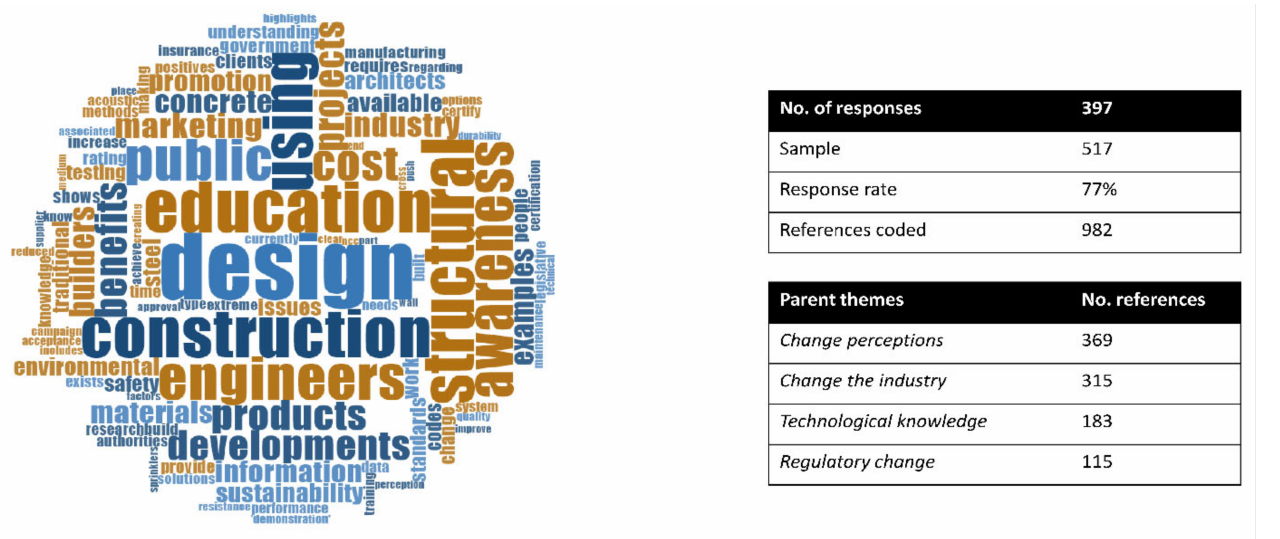
Figure 12. Word Cloud: what can be done to improve adoption of timber in medium and high-rise markets? In the responses, the top-ten most used words relevant for the adoption of timber in multi-storey buildings are: ‘design’ (word count: 83), ‘education’ (79), ‘use’ (63), ‘awareness’ (59), ‘engineers’ (58), ‘structures’ (57), ‘construction’ (56), ‘public’ (53), ‘fire’ (52) and ‘cost’